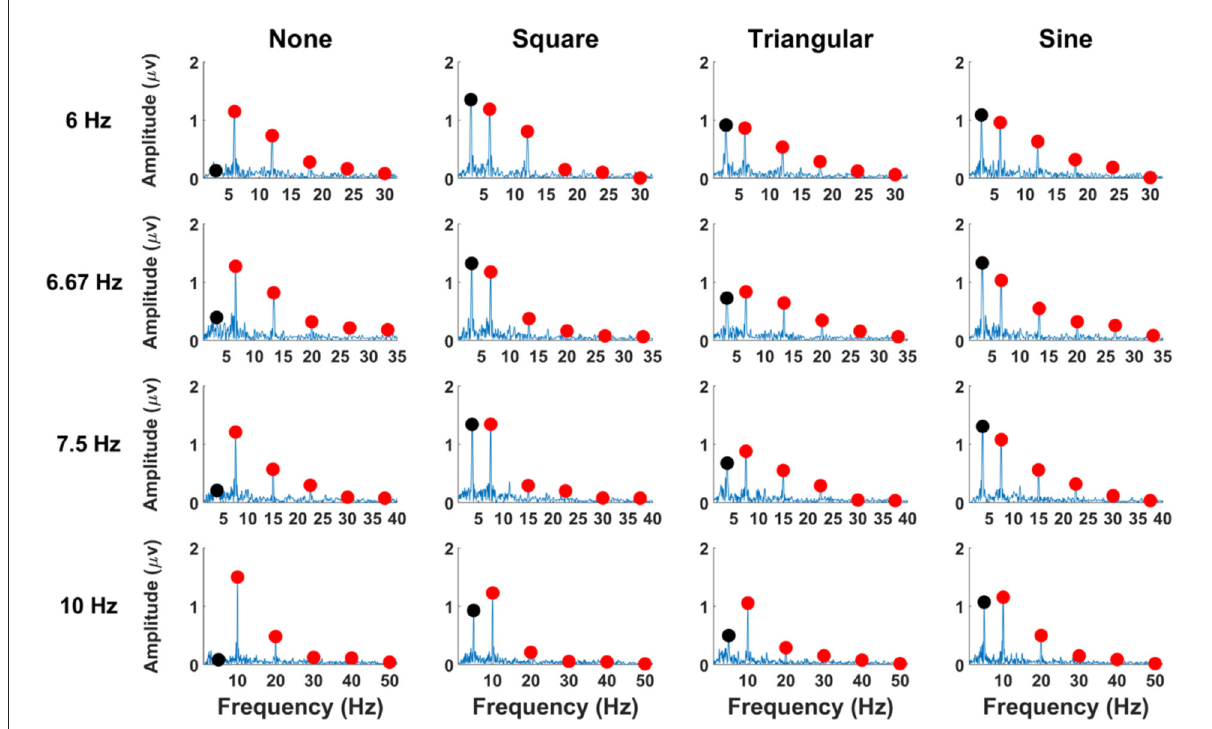
FIGURE7 SSVEP amplitudes of averaged EEG signals over all participants for PRS-based hybrid visual stimuli at the Oz electrode. Red circles indicate the stimulation frequencies and their harmonics, and black circles represent the subharmonic frequencies.